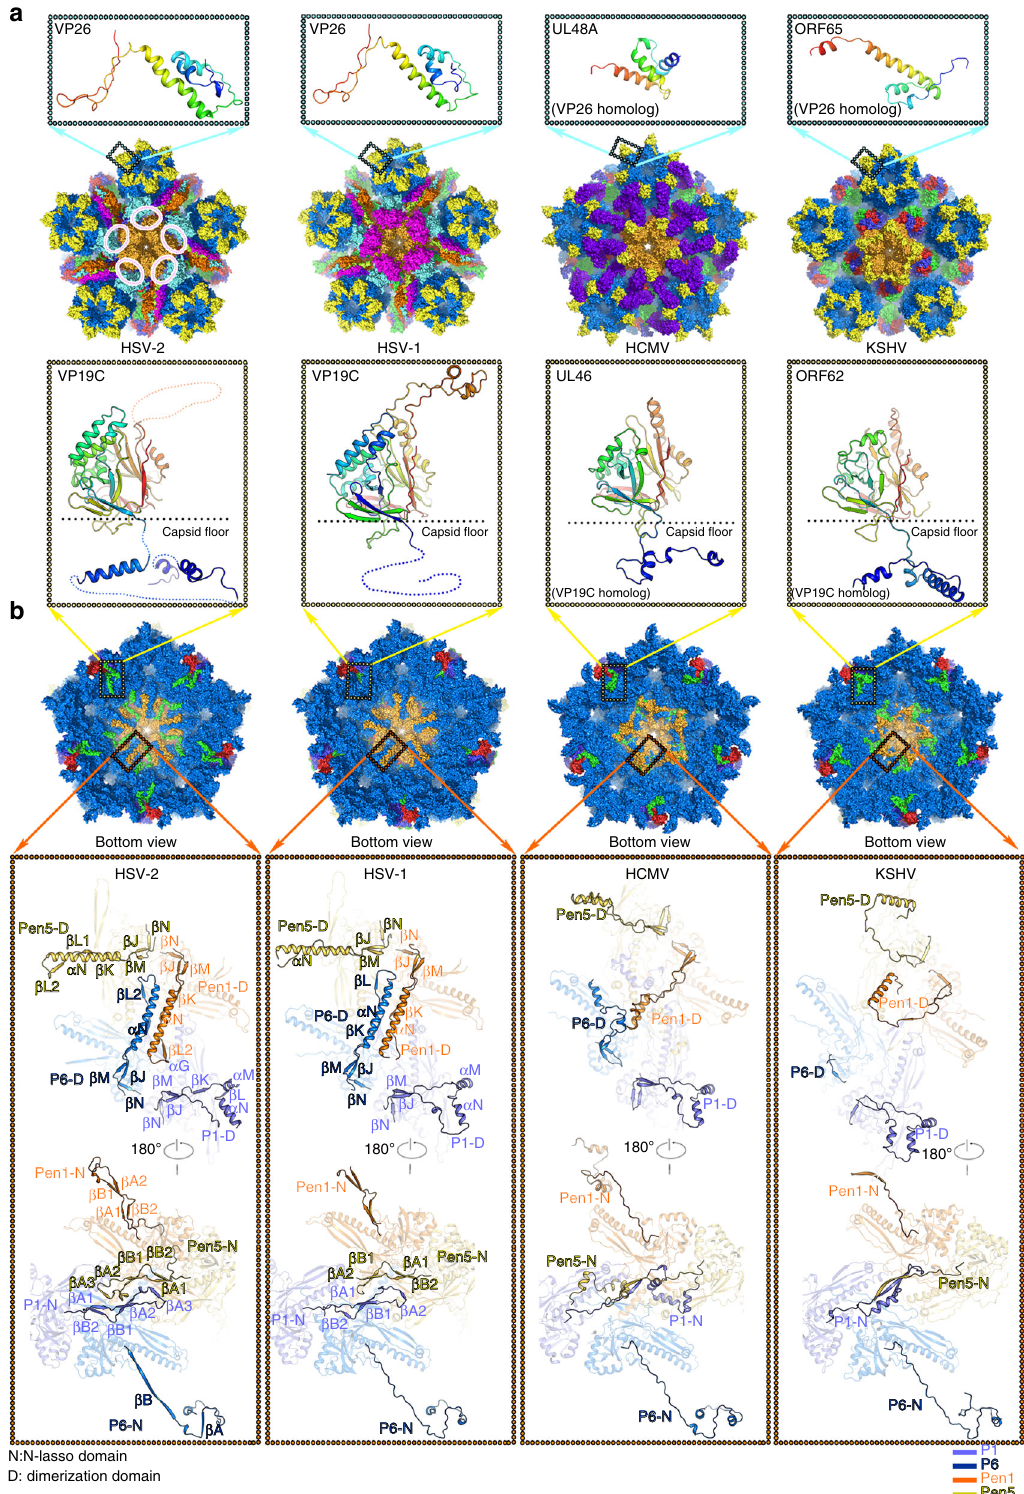
Fig. 2 Structural comparison of the pentonal vertex of α -, β -, and γ -herpesviruses. Surface representations of the pentonal vertex from α - (HSV-1, HSV-2), β - (HCMV), and γ -herpesviruses (KSHV) viewed from the top ( a ) and bottom ( b ) are shown. The color scheme is same as Fig. 1c, the β -herpesvirus- speci fi c tegument protein pp150 is colored in purple. Red-colored elliptical lines indicate the UL25-1 C domains that were not modeled because of its fl exibility in HSV-2. The major structural differences observed in α -, β -, and γ -herpesviruses are marked by cyan (for VP26 and its homologs), yellow (for VP19C and its homologs) and red boxes (for inner capsid around the interface of Pen1, Pen5, P1, and P6). Enlarged views of the structural differences (boxed) are shown with secondary structural elements colored and labeled. For a and b , rainbow ribbon models show individual proteins (blue N terminus through green and yellow to red C